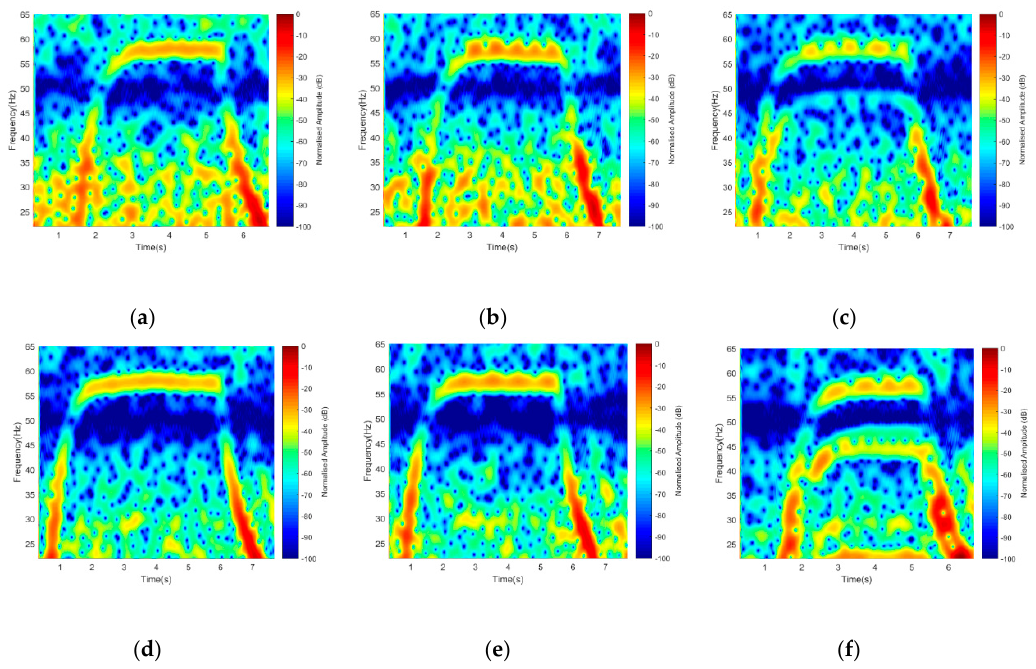
Figure 14. STFT (short-time Fourier transform) for default blades for 5 GHz ( a ) 1-rotor, ( b ) 2-rotors, and ( c ) 4-rotors, and 7 GHz ( d ) 1-rotor, ( e ) 2-rotors, and ( f ) 4-rotors signatures.